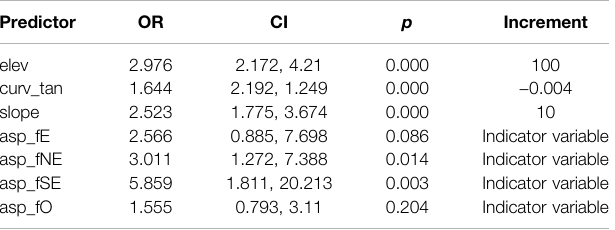
TABLE 3 | Result of logistic regression for current realized niche, validated with spatial CV.